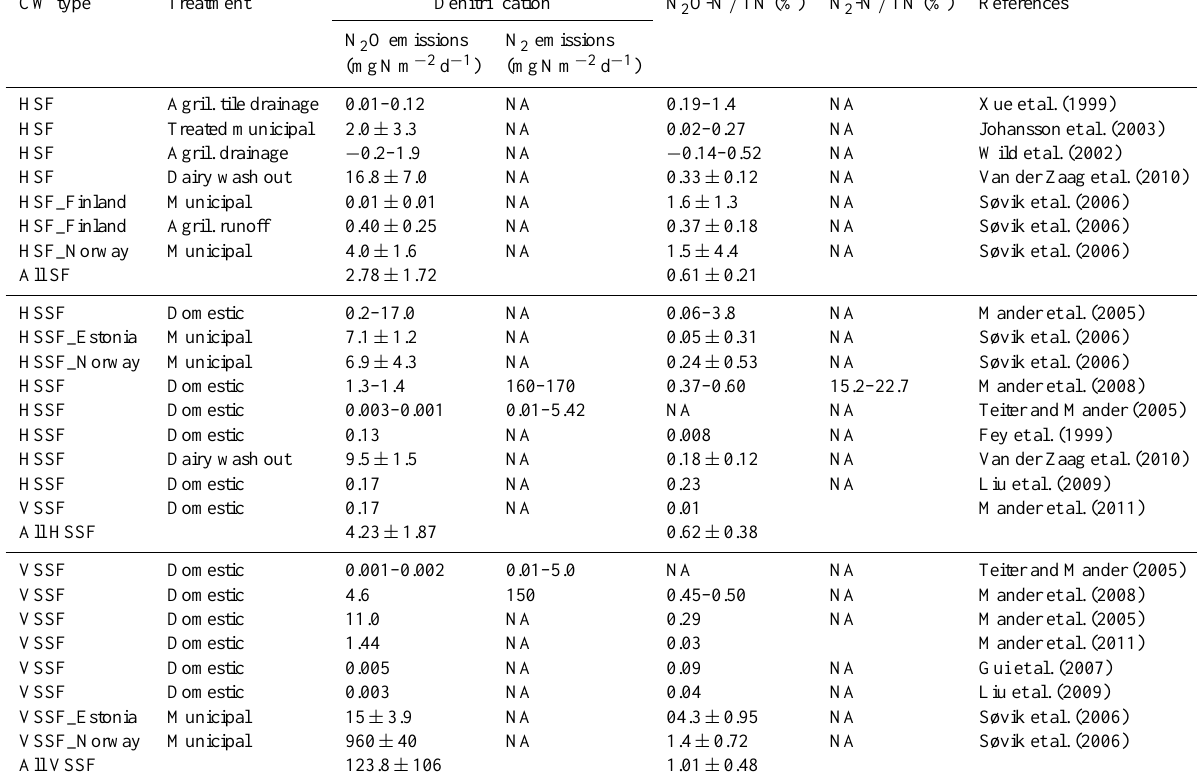
Table 3. Nitrous oxide (N 2 O) emissions (mgNm − 2 d − 1 ); N 2 emissions (mgNm − 2 d − 1 ) and N 2 O emission factor (N 2 O / TN input × 100) in various type of CWs; mean standard error ( ± SE) was presented for N 2 O emission factor; NA – data not